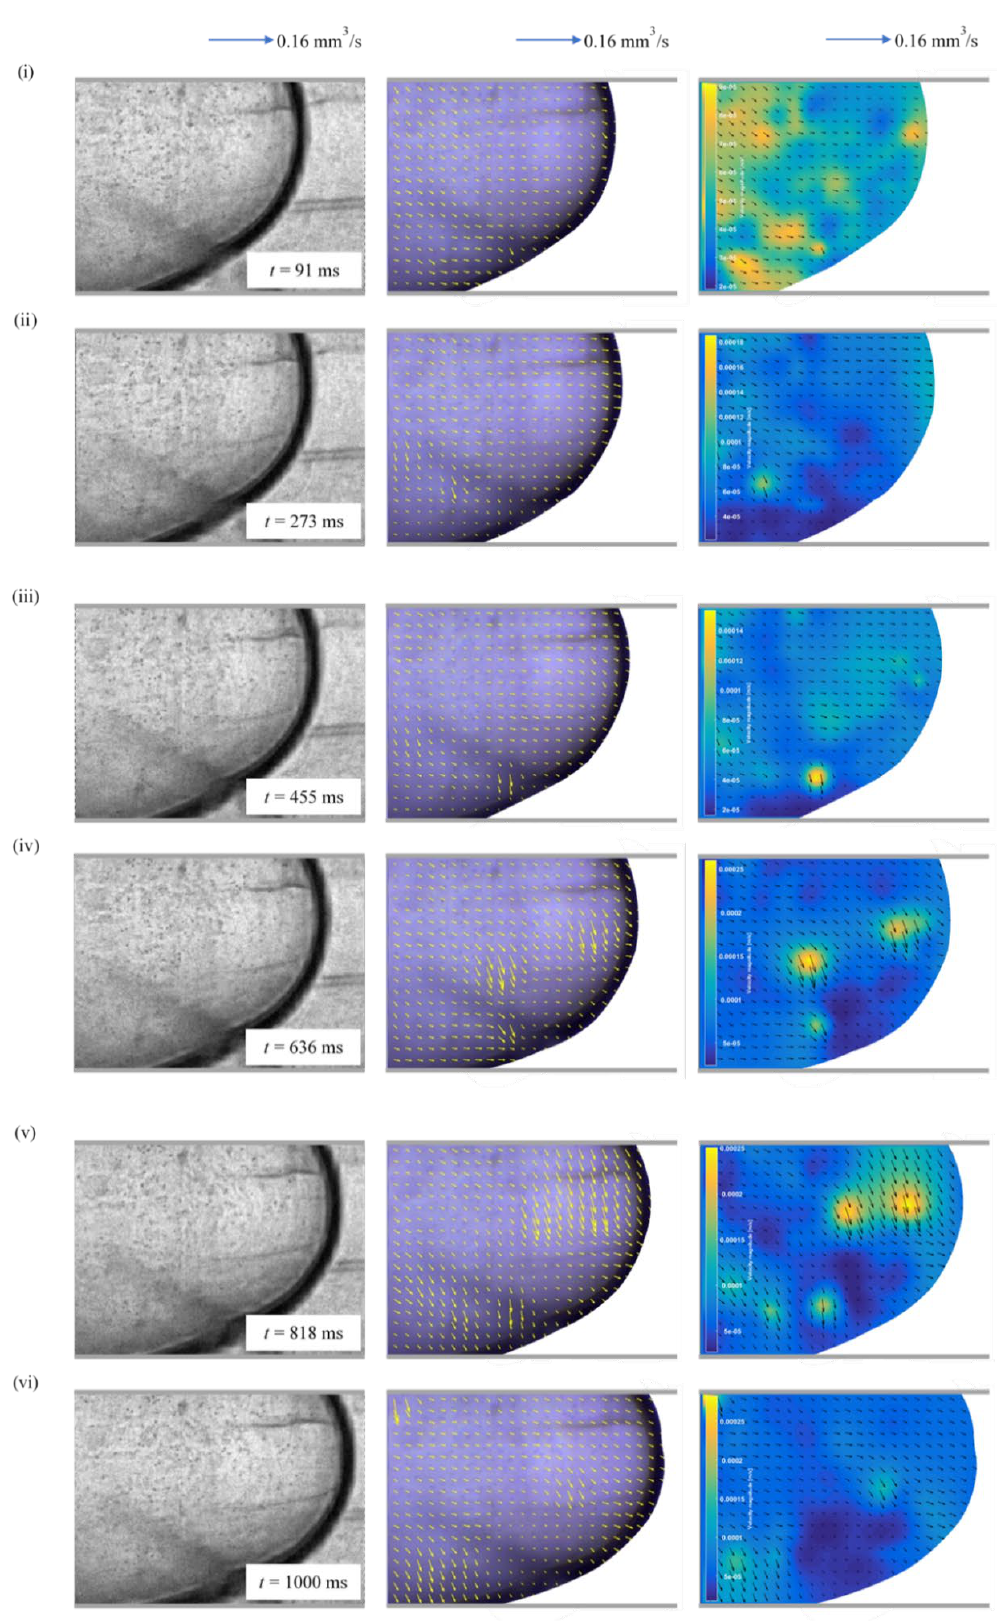
Figure 7. Pre-processing image, vector and velocity magnitude for the offset T-junction microchannel with a radius of 750 µm at ( i ) 91 ms, ( ii ) 273 ms, ( iii ) 455 ms, ( iv ) 636 ms, ( v ) 818 ms and ( vi ) 1000 ms.